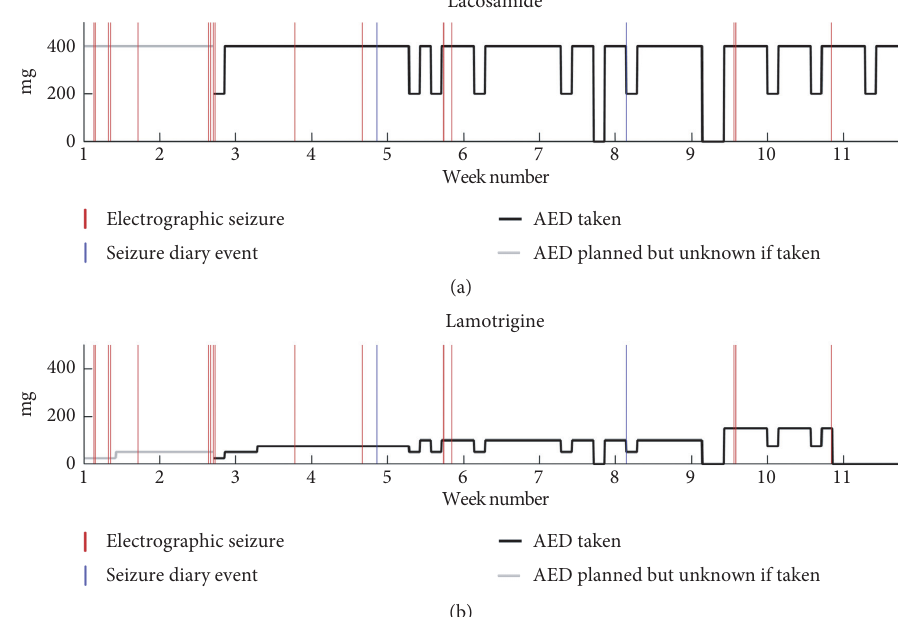
Figure 2: Overview of the monitoring period AED dosages plotted over time for lacosamide (a) and lamotrigine (b). Solid black line is the daily dose taken. It can drop 50% or 100% on some days indicating one or two missed doses. It is greyed out when no information about the dose taken was available. Red vertical lines indicate electrographical seizure. The two first seizures were focal to bilateral tonic-clonic seizures. Blue vertical lines indicate a patient event diary entry. These two do not overlap with any of the electroencephalographic